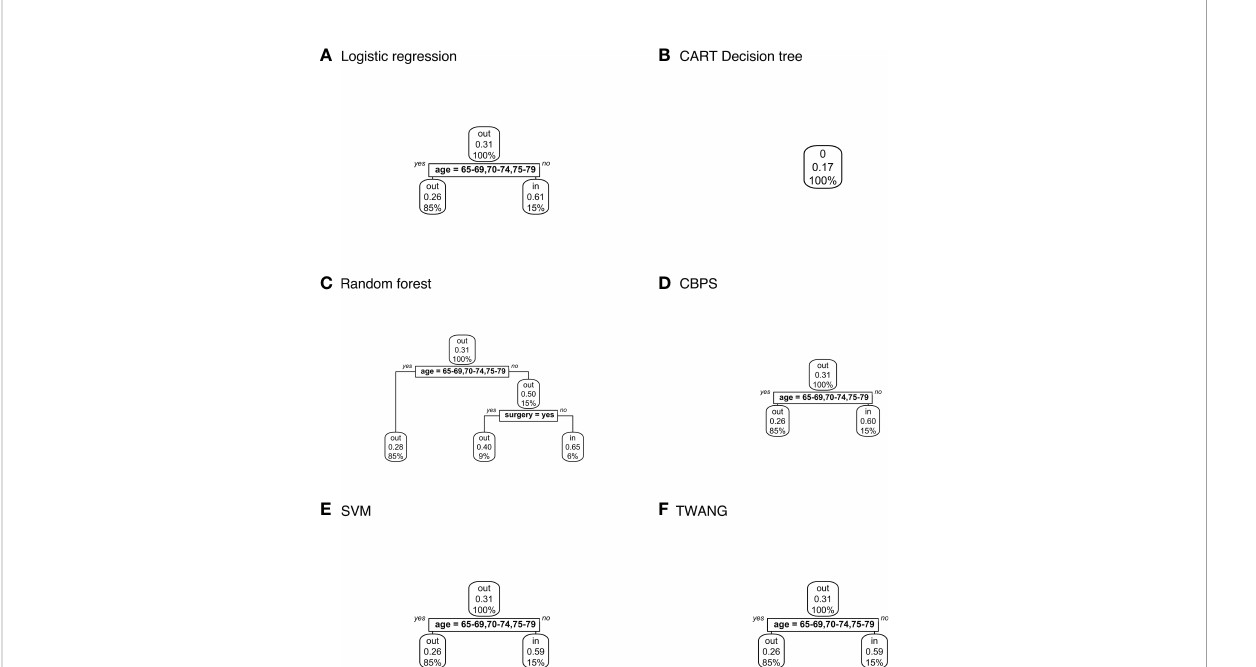
FIGURE 5 Population-level explainer decision trees for glioblastoma data comparing radiation vs. combined modality therapy. Trees classify subjects as matched ( “ in ” ) or unmatched ( “ out ” ) given observed features using propensity scores estimated by (A) logistic regression; (B) CART decision tree; (C) random forest; (D) covariate balancing propensity scores; (E) support vector machines; and (F) the Toolkit for Weighting and Analysis of Nonequivalent Groups. Each node lists the probability of the corresponding classi fi cation for the set of features listed above it and the percentage of subjects that exhibit that